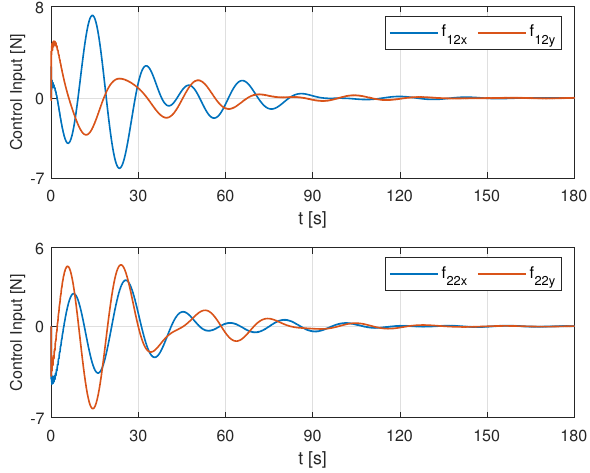
Figure 13. Actuator forces on the